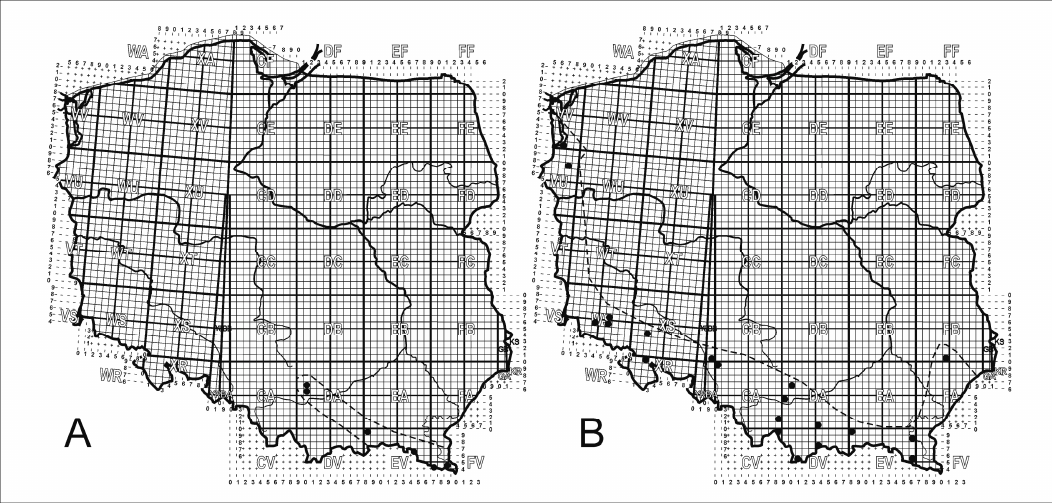
Figure 6. Species with their eastern range boundaries in Poland: ( A ) Olodiscus misella , ( B ) Cilliba erlangensis ; black dots—recorded occurrences of the